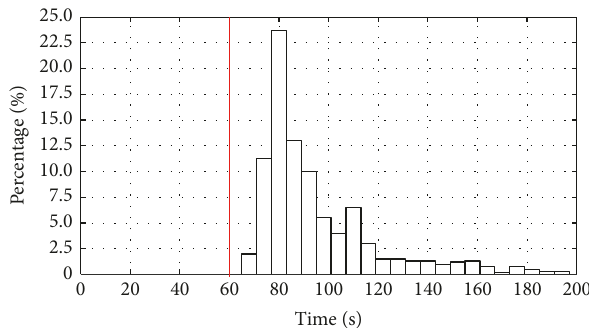
Figure 11: Particle distribution for final decay tank model.